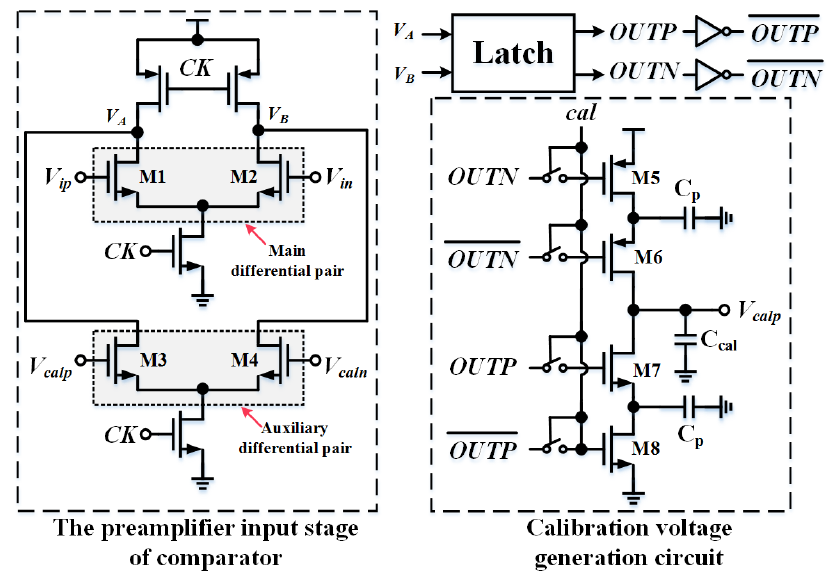
Figure 5. The diagram of comparator’s background offset calibration.